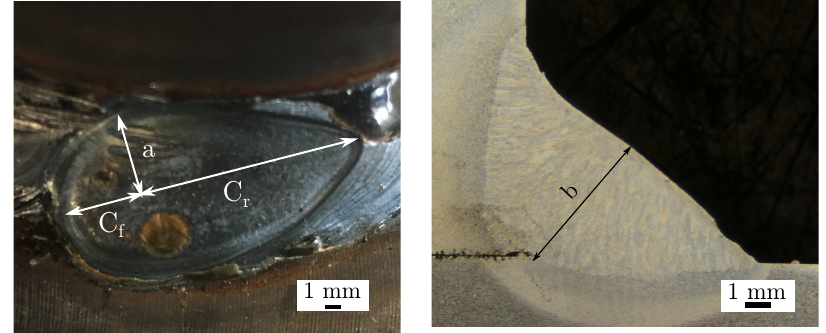
Figure 6. Goldak’s heat source parameters obtained directly by the fusion